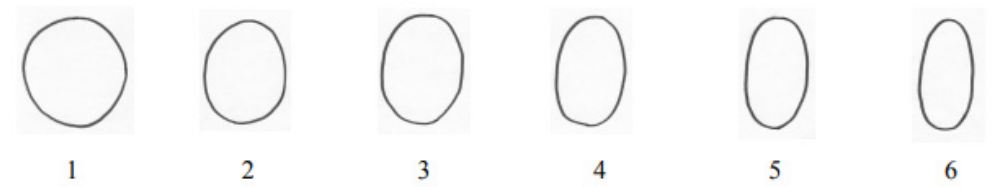
Figure 1. UPOV morphological descriptors for potato tuber shape. 1: Round; 2: Short oval; 3: Oval; 4: Long oval; 5: Long; 6: Very long. [17].